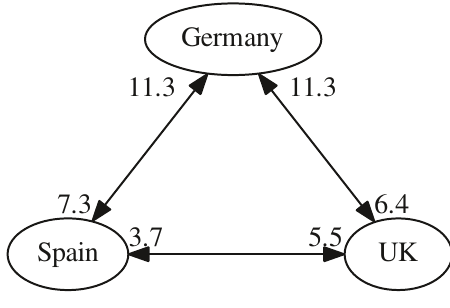
Fig. 4. The global distance between three distributed teams. Taken from